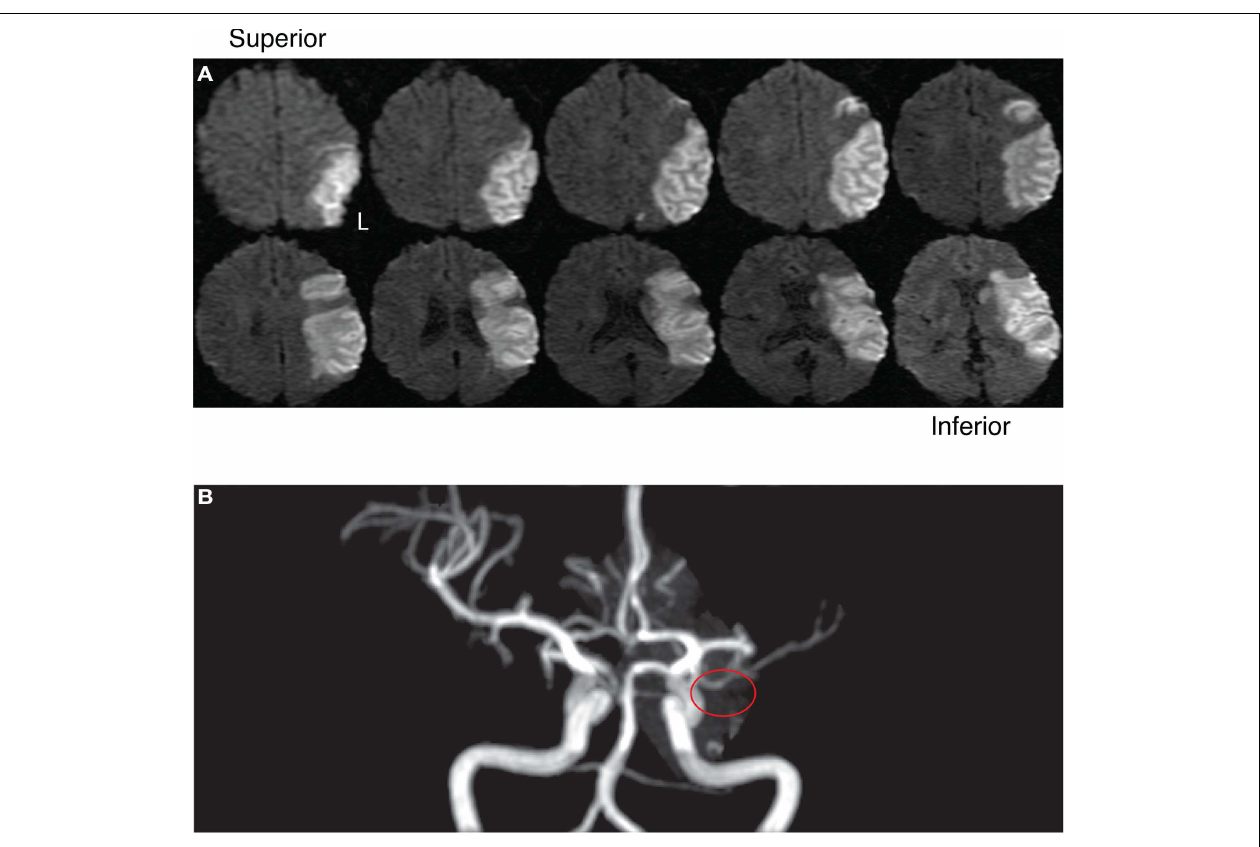
FIGURE 1 | (A) Diffusion-weighted images of Case AA’s left-hemisphere lesion. (B) Angiography and origin of Case AA’s left-hemisphere